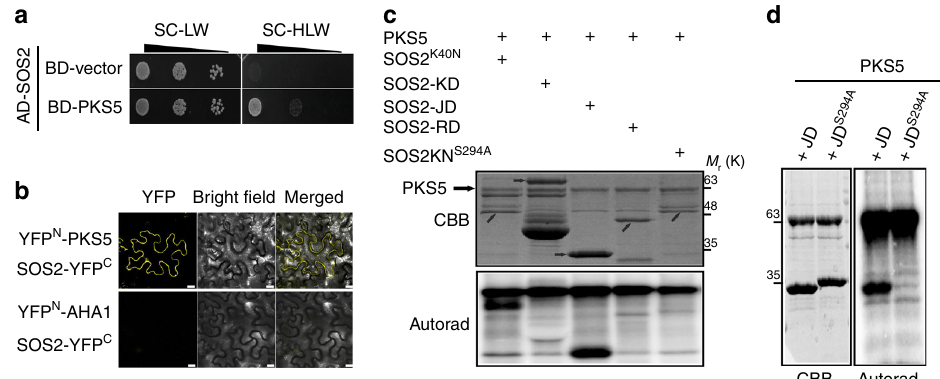
Fig. 1 PKS5 interacts with SOS2 and phosphorylates SOS2 Ser294 . a Yeast two-hybrid assay showing that SOS2 interacts with PKS5. No interaction was observed when using an empty-vector control (BD-vector). b BiFC assay of the SOS2/PKS5 interaction in N. benthamiana . Plasmids containing YFP N -PKS5 and SOS2-YFP C or YFP N -AHA1 and SOS2-YFP C were co-transformed into N. benthamiana leaves. Two days post-in fi ltration, the YFP fl uorescence was detected by confocal microscopy. Scale bars, 50 μ m. c In vitro kinase assay showing that PKS5 phosphorylates SOS2 Ser294 . The recombinant proteins were incubated in kinase buffer at 30 °C for 30 min and separated by SDS – PAGE. Arrow indicates the target protein. d In vitro kinase assay showing that PKS5 phosphorylates SOS2-JD but not SOS2-JD S294A . JD, SOS2-JD; JD S294A , SOS2-JD S294A . CBB Coomassie brilliant blue, Autorad autoradiograph. Source data of c and d are provided in the Source Data fi